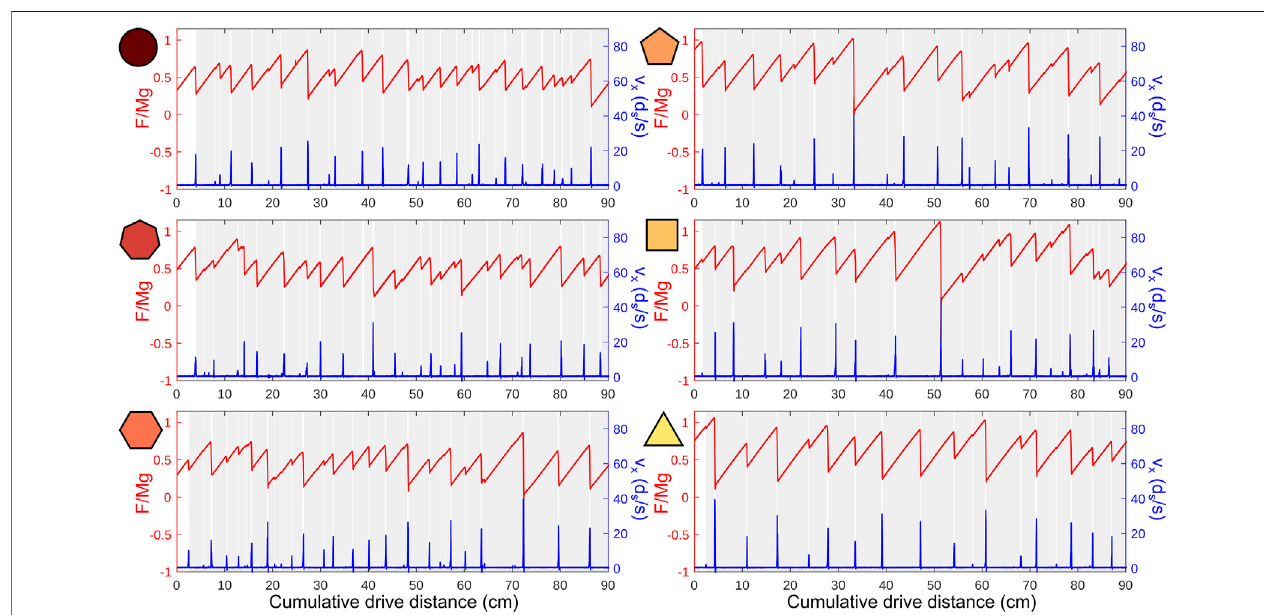
FIGURE 3 | Sample time series for all shapes from disks, heptagons, and hexagons (left column) to pentagons, squares, and triangles (right column). The normalizedpullingforceisplottedinredontheleftaxisandthehorizontalvelocityofthesliderisplottedinblueontherightaxis.Detectedstickingperiods(with v x ~0)are indicated by gray regions.